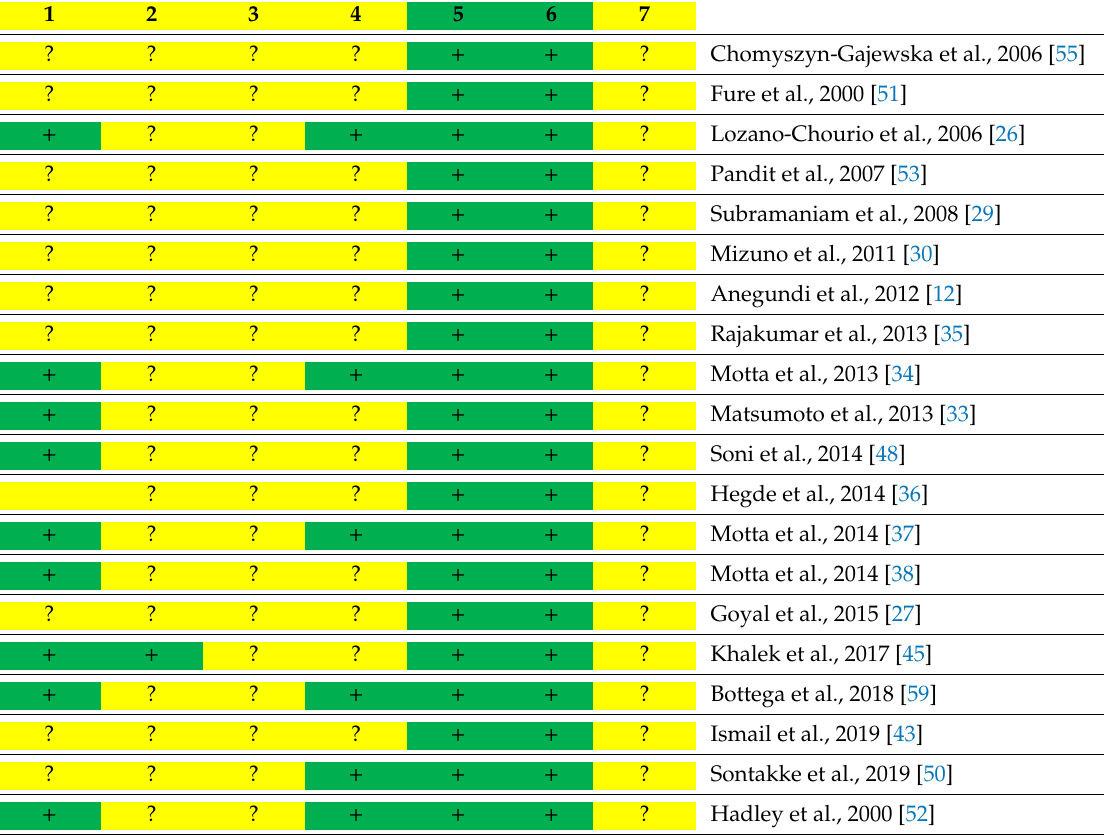
Table A1. Evaluation of quality assessment of the randomized clinical trials included in this systematic